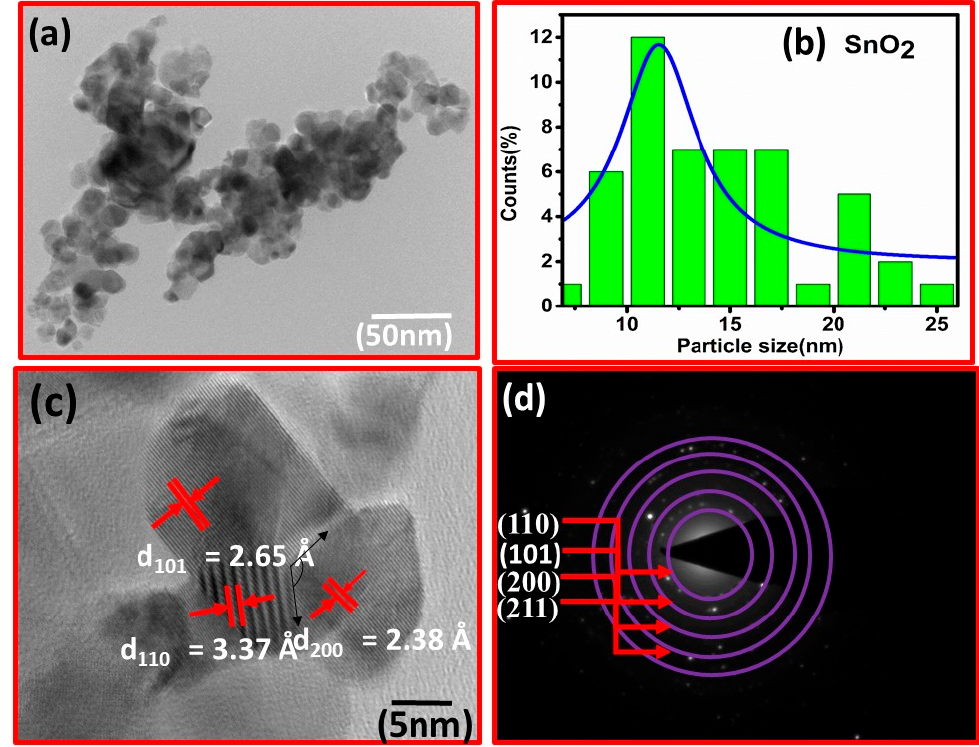
Figure 2. ( a ) TEM image of sensing base material. ( b ) Histogram analysed by Image-J software. ( c ) HRTEM image of nanoparticles. ( d ) Shows a different plane in the SAED pattern.